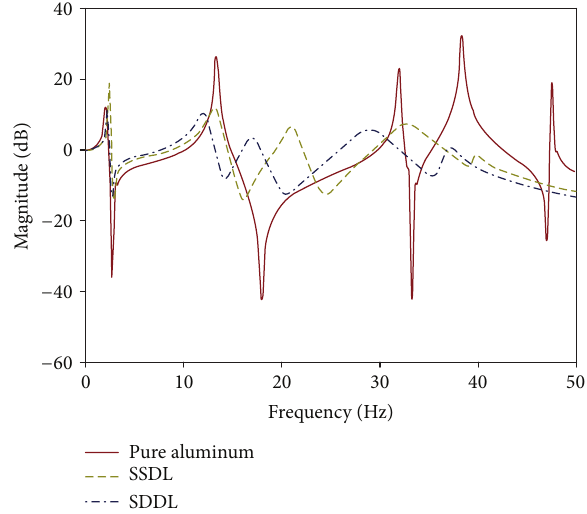
Figure 13: Frequency response of cylindrical aluminum panel in case of pure aluminum, SSDL, and SDDL ( 𝑎 = 0.2 m, 𝜙 = 0.01 rad, = 5 mm, 𝑡 = 2 mm, 𝑡 = 5 mm, 𝑡 = 3 mm, 𝑡 = 1 mm, 𝑅 = 20 m, 𝑡 1 2 3 4 5 = 4 mm, 𝑡 = 1 mm, and 𝑡 = 3 𝑡 6 7 8